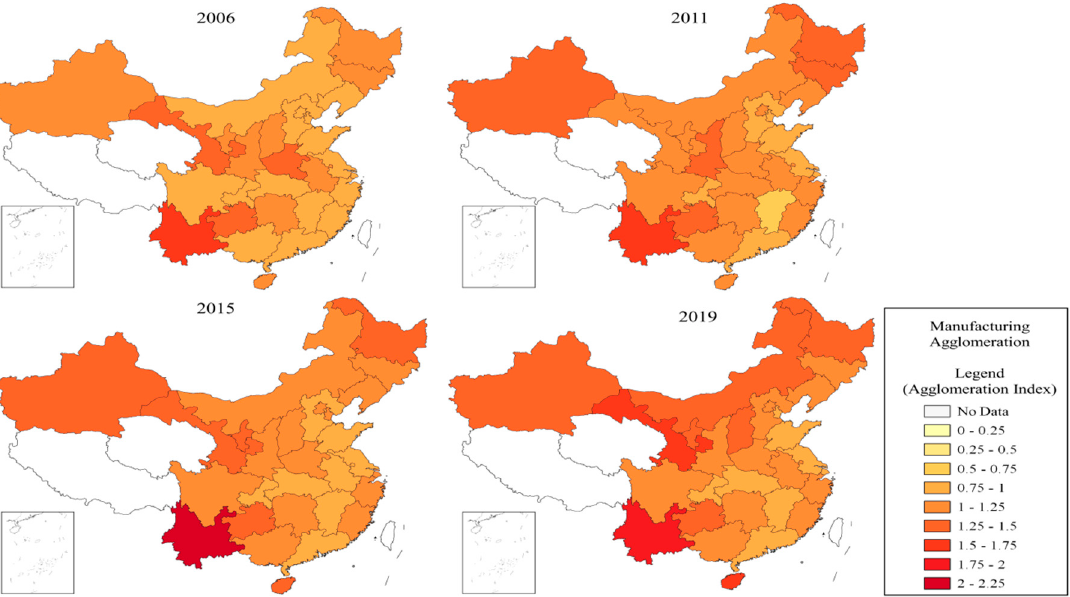
Figure 8. Distribution of manufacturing agglomeration in different provinces of China from 2006 to 2019.